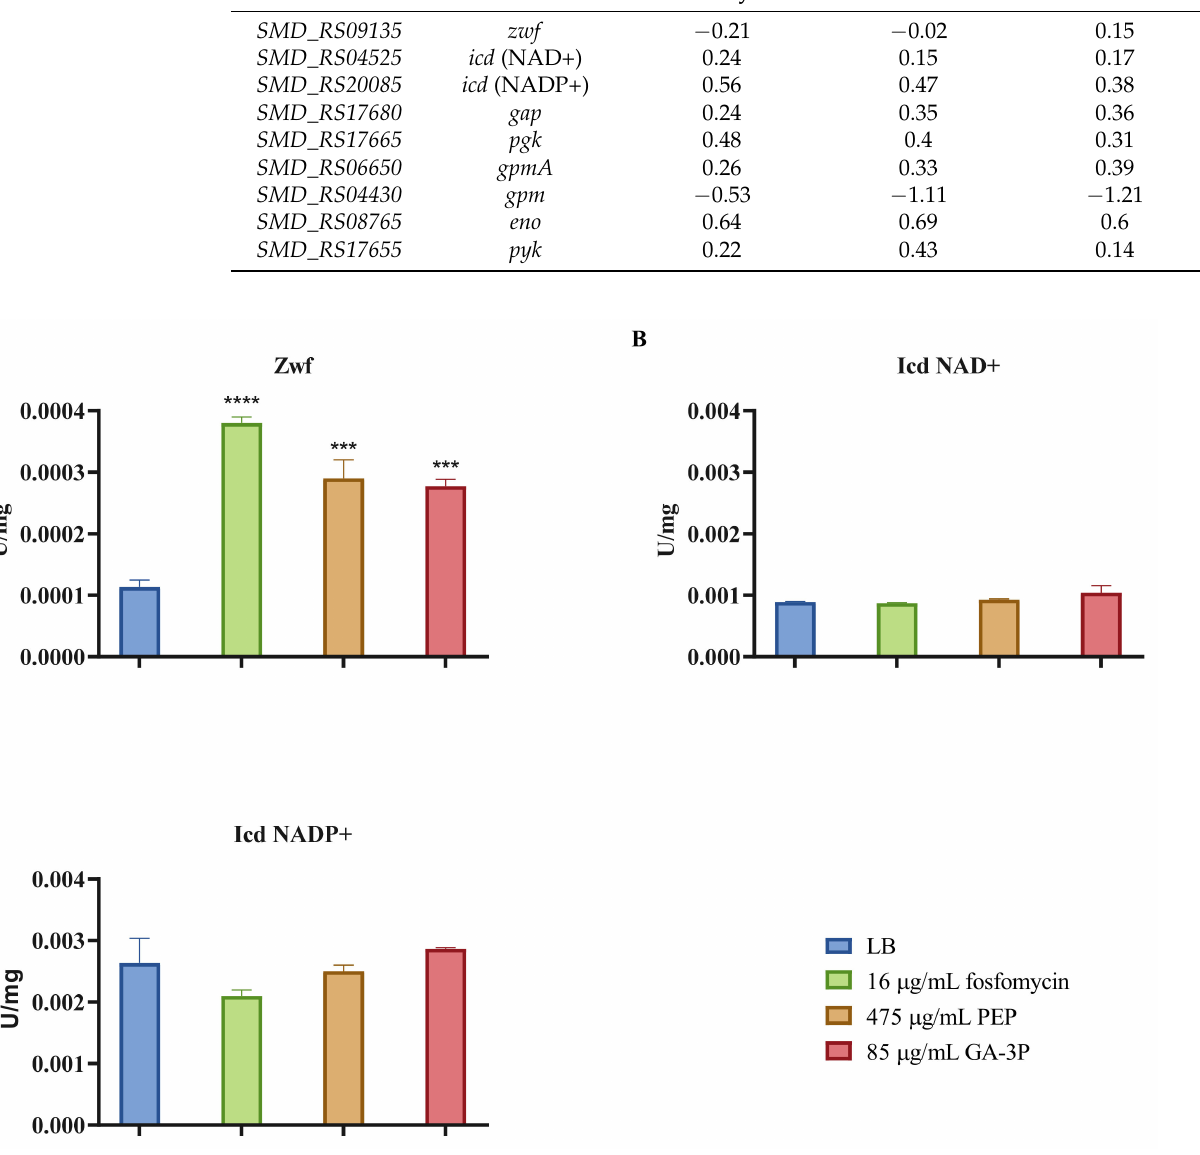
Figure 6. Enzymatic activity of the main dehydrogenases from the D457 strain in the exponential growth phase without treatment, and after 1 h of fosfomycin, PEP, and GA-3P treatment: ( A ) Zwf glucose-6-phosphate dehydrogenase activity; ( B ) Icd (NAD+) isocitrate dehydrogenase NAD+ ac- tivity; ( C ) Icd (NADP+) isocitrate dehydrogenase NADP+ activity. Error bars indicate standard deviations for the results from three independent replicates. As shown, the activity of Zwf was higher in treated samples. Statistical significance was calculated by unpaired two-tailed t -test; ***: p < 0.007; ****: p <